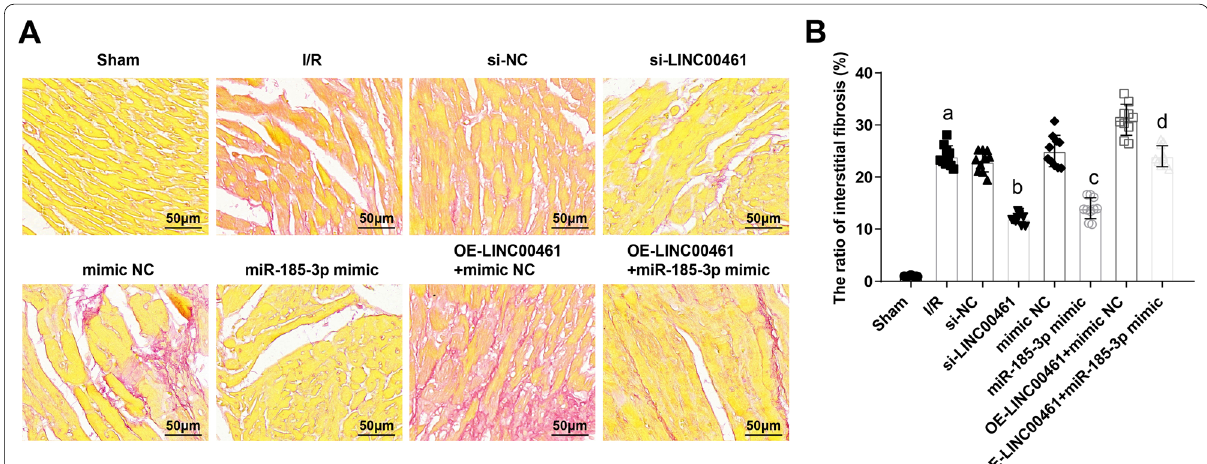
Fig. 4 Restoration of miR-185-3p or depletion of LINC00461 reduces myocardial collagen hyperplasia and fibrosis in I/R mice. A Degree of myocardial fibrosis in each group of mice. B Comparison of myocardial fibrosis area in each group of mice. a P < 0.05 vs. the sham group. b P < 0.05 vs. the si-NC group. c P < 0.05 vs. the mimic-NC group. d P < 0.05 vs. the OE-LINC00461